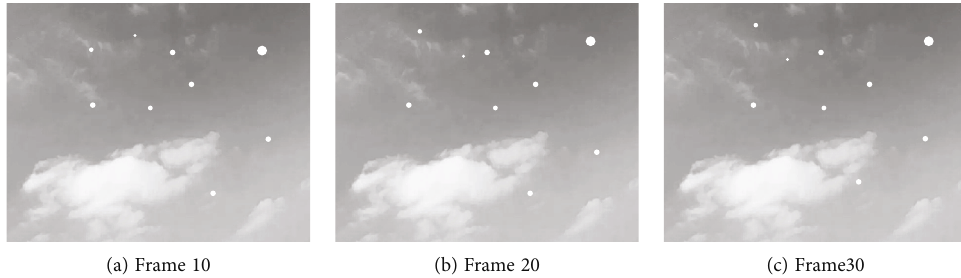
Figure 5: Original infrared image of amblyopia.